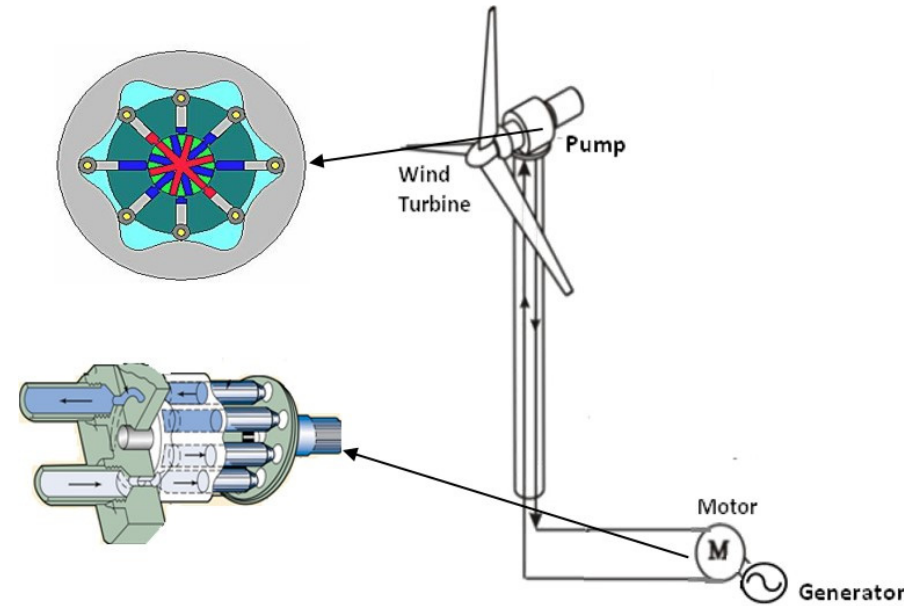
Figure 1. Schematic of a hydrostatic drive wind turbine